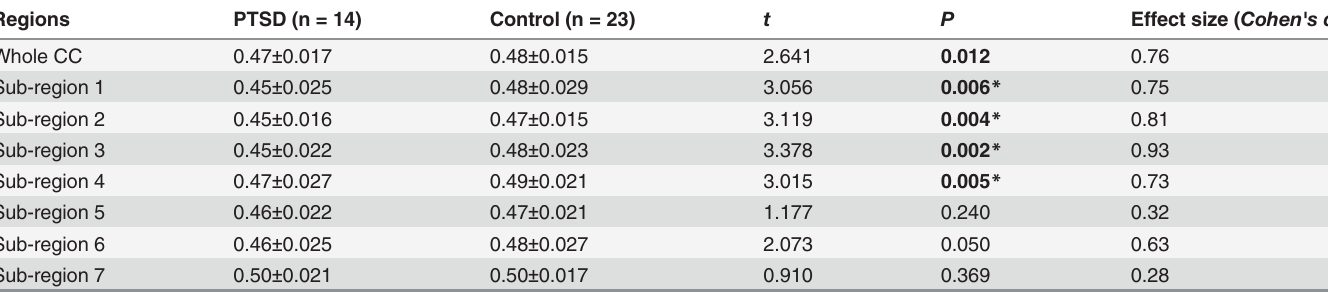
Table 3. Fractional anisotropy values of the tract of interest (TOI) in corpus callosum (Mean ± SD). Regions